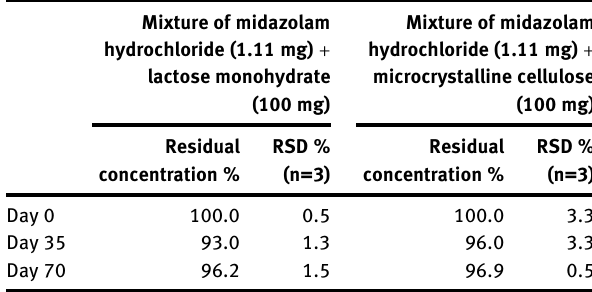
Table  : Evolution of relative midazolam content (%) in the two